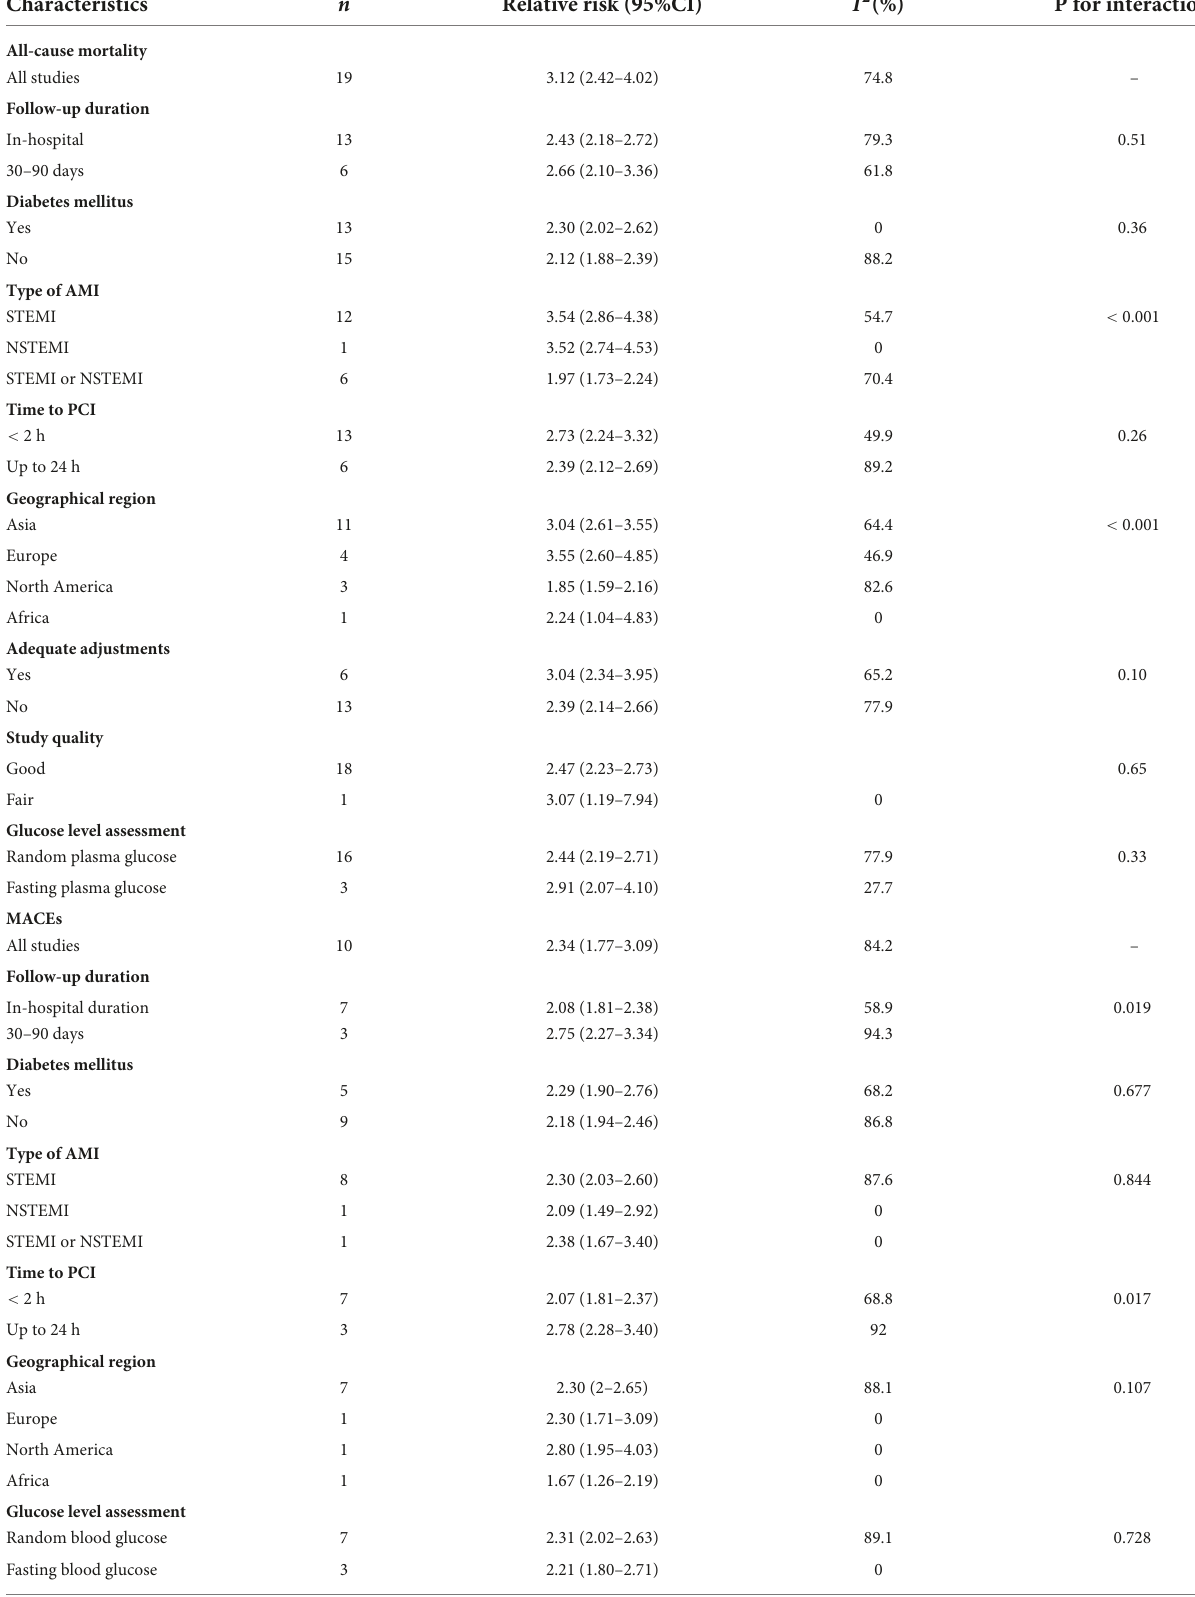
TABLE 1 Subgroup analysis of association between admission hyperglycemia and short-term outcomes in patients with AMI. Characteristics n Relative risk (95%CI) I 2 (%) P for